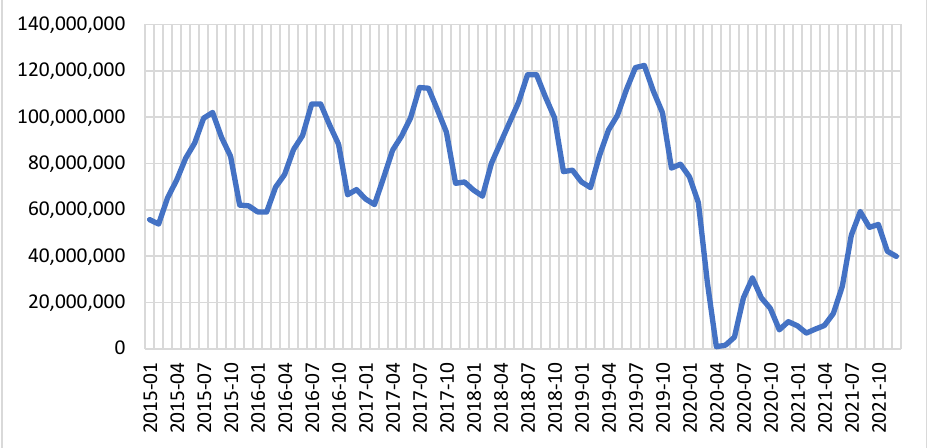
Figure 2. Number of passengers served (in persons). Source: own elaboration. Due to the features of the series, we decided to use the exponential smoothing method with additive seasonality. The results obtained with the use of Statistica 13.3 soft- ware are shown in Figure 3. Figure 3. Exponential smoothing of kerosene-type jet fuel supplies. Source: own elaboration. The values of the forecasts obtained on the basis of this are presented in Table 1, and the forecast errors are in Table 2.